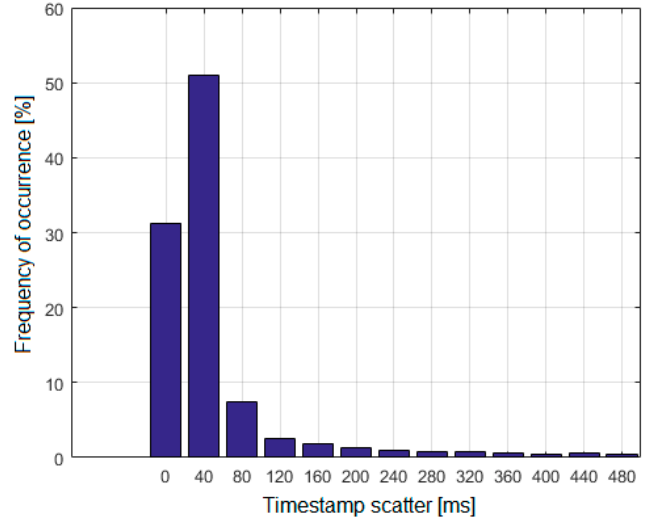
Figure 17. Scatter distribution of timestamps in voice data sets.